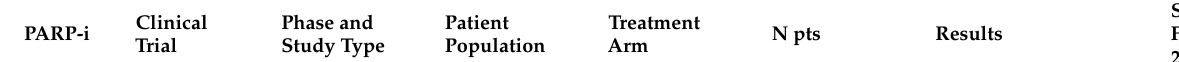
Table 3. Main clinical trials and results of PARP-i in mCRPC patients with a HR